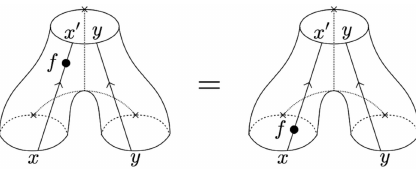
Figure 13 . The transition amplitude does not depend on whether a topological point operator f ∈ Hom( x, x 0 ) is inserted before or after the multiplication M